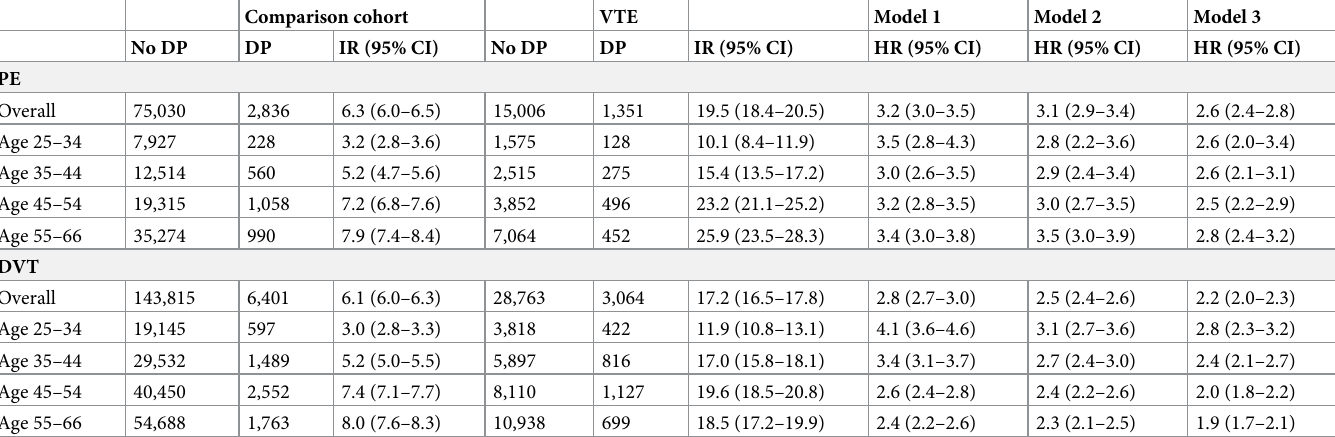
Model 1: unadjusted model controlled for matching variables by study design. Model 2: adjusted for SES (education, employment status, and income) and obesity. Model 3: adjusted for SES score (education, employment status, and income), obesity, cancer, coronary heart disease (including atrial fibrillation), diabetes, stroke, COPD, acute kidney failure and chronic kidney disease, surgery 3 months prior to the VTE/index date, and Charlson Comorbidity Index score, excluding comorbidities already adjusted for. CI, confidence interval; COPD, chronic obstructive pulmonary disease; DP, disability pension; DVT, deep vein thrombosis; HR, hazard ratio; IR, incidence rate; PE, pulmonary embolism; SES, socioeconomic status; VTE, venous thromboembolism. CI: 2.5 to 4.2), after adjustment for SES and comorbidities (Model 3). These risk estimates